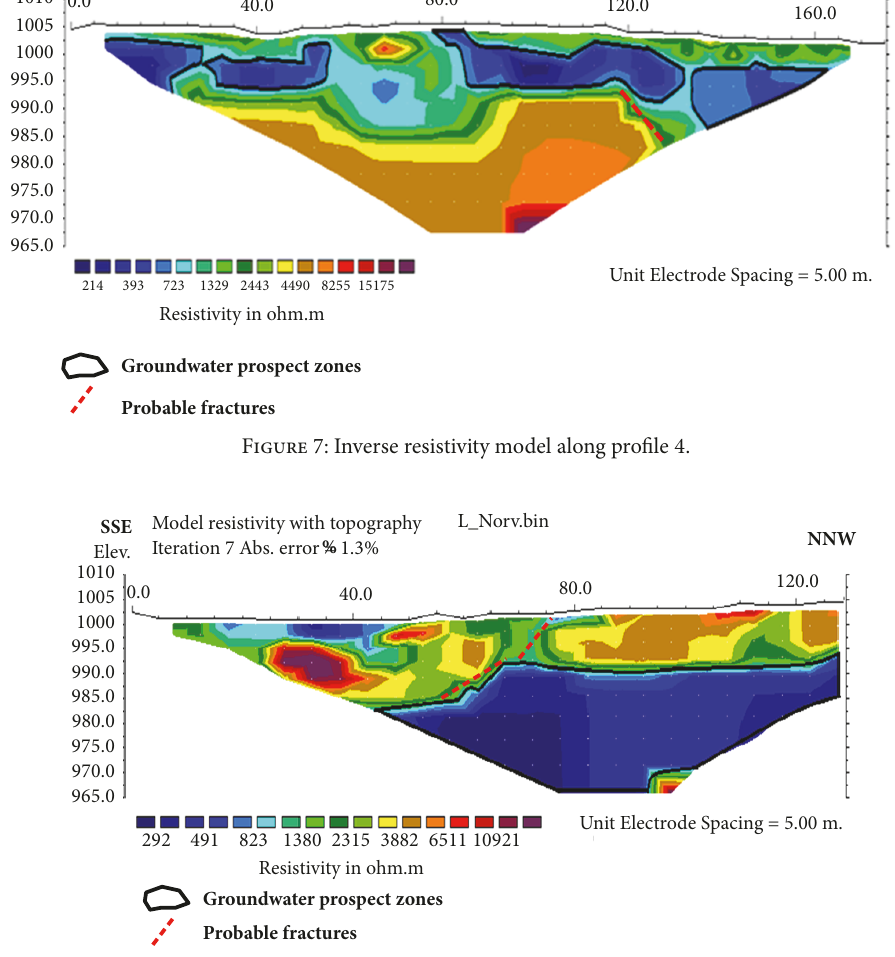
Figure 8: Inverse resistivity model along profile